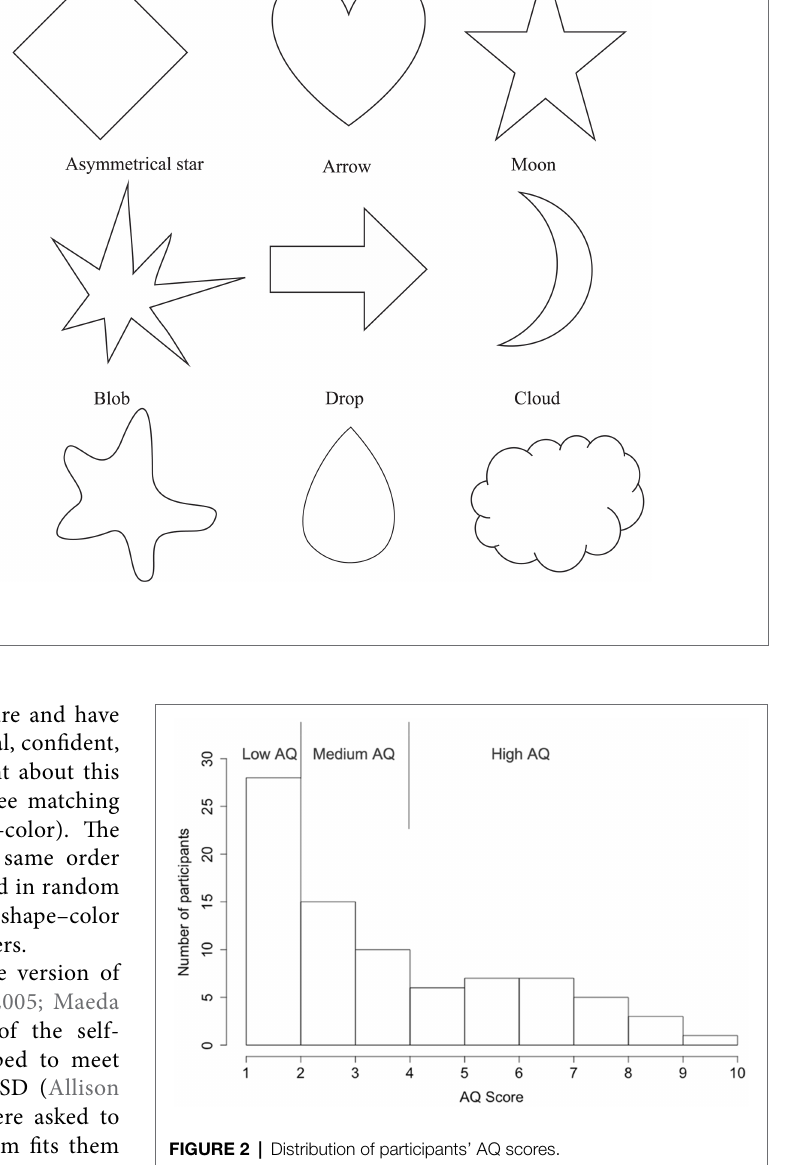
FIGURE 2 | Distribution of participants’ AQ scores.